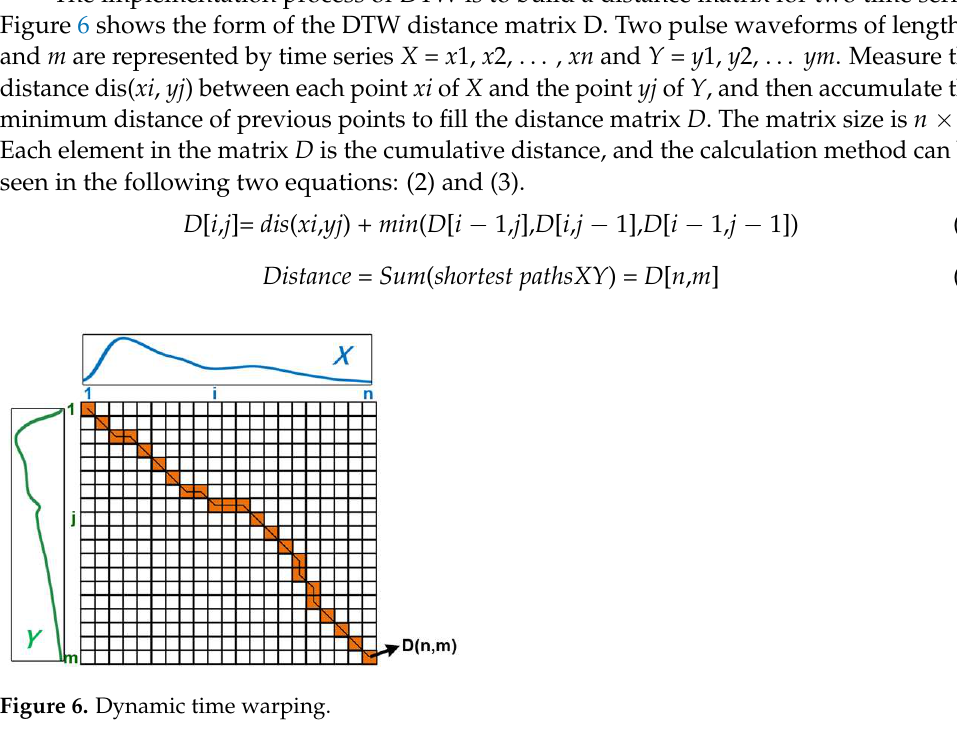
Figure 7. Matched points between two pulse waveforms using DTW ( a , b ) and improved DTW ( c , d ).